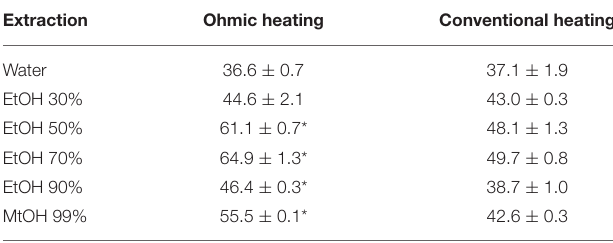
TABLE 1 | Chemical, nutritional, and elementary (minerals) composition of dried Red eggplant. Proximate composition Elemental composition